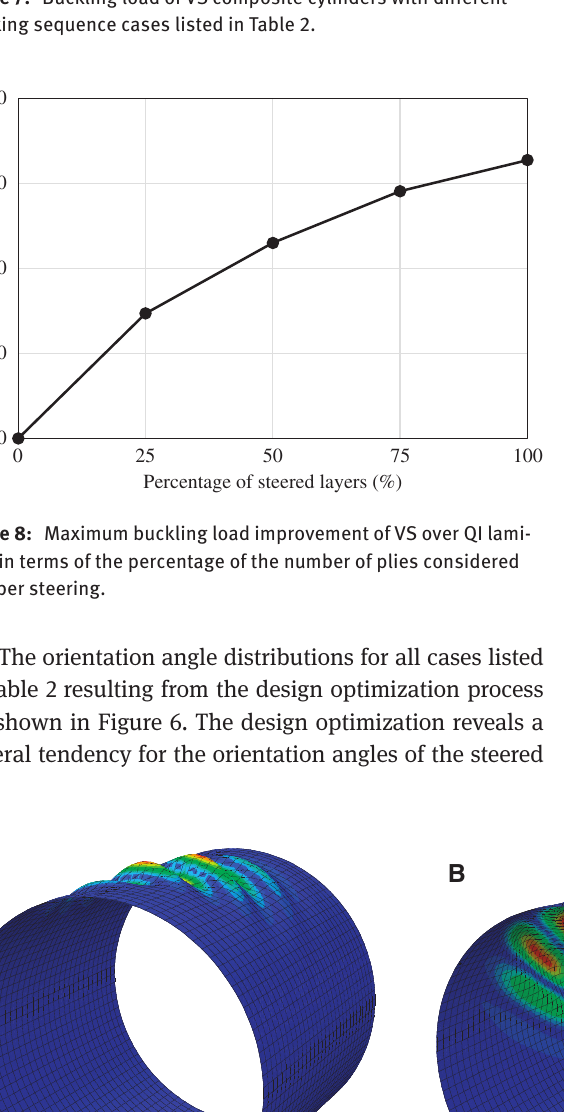
Figure 9: Resultant normal section force in QI and VS cylinder (case 8).